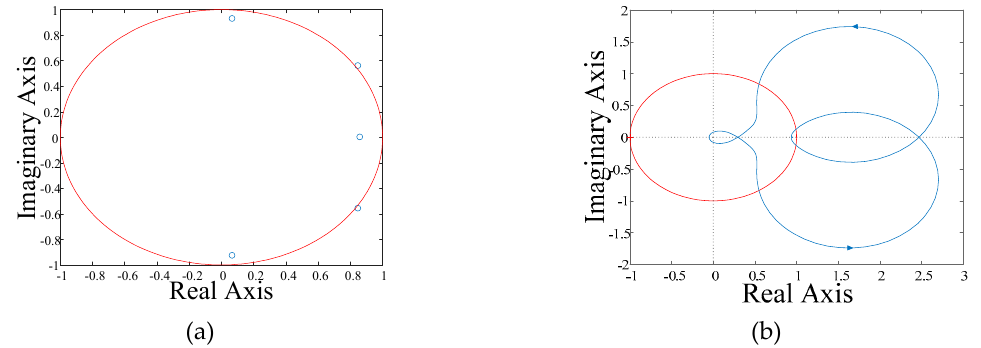
Figure 10. Sufficient stability criterion under resistor-inductor-capacitor (RLC) load. (a) Pole diagram of T(z) under RLC load. (b) Nyquist diagram of H(z) under RLC load.